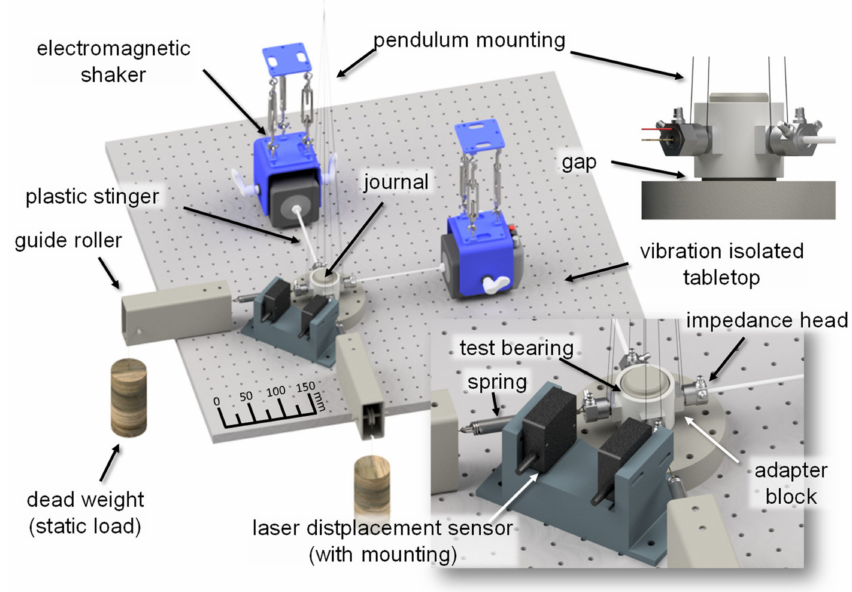
Figure 1. Design of test rig (the dead weights are further away from center than shown: app. 1